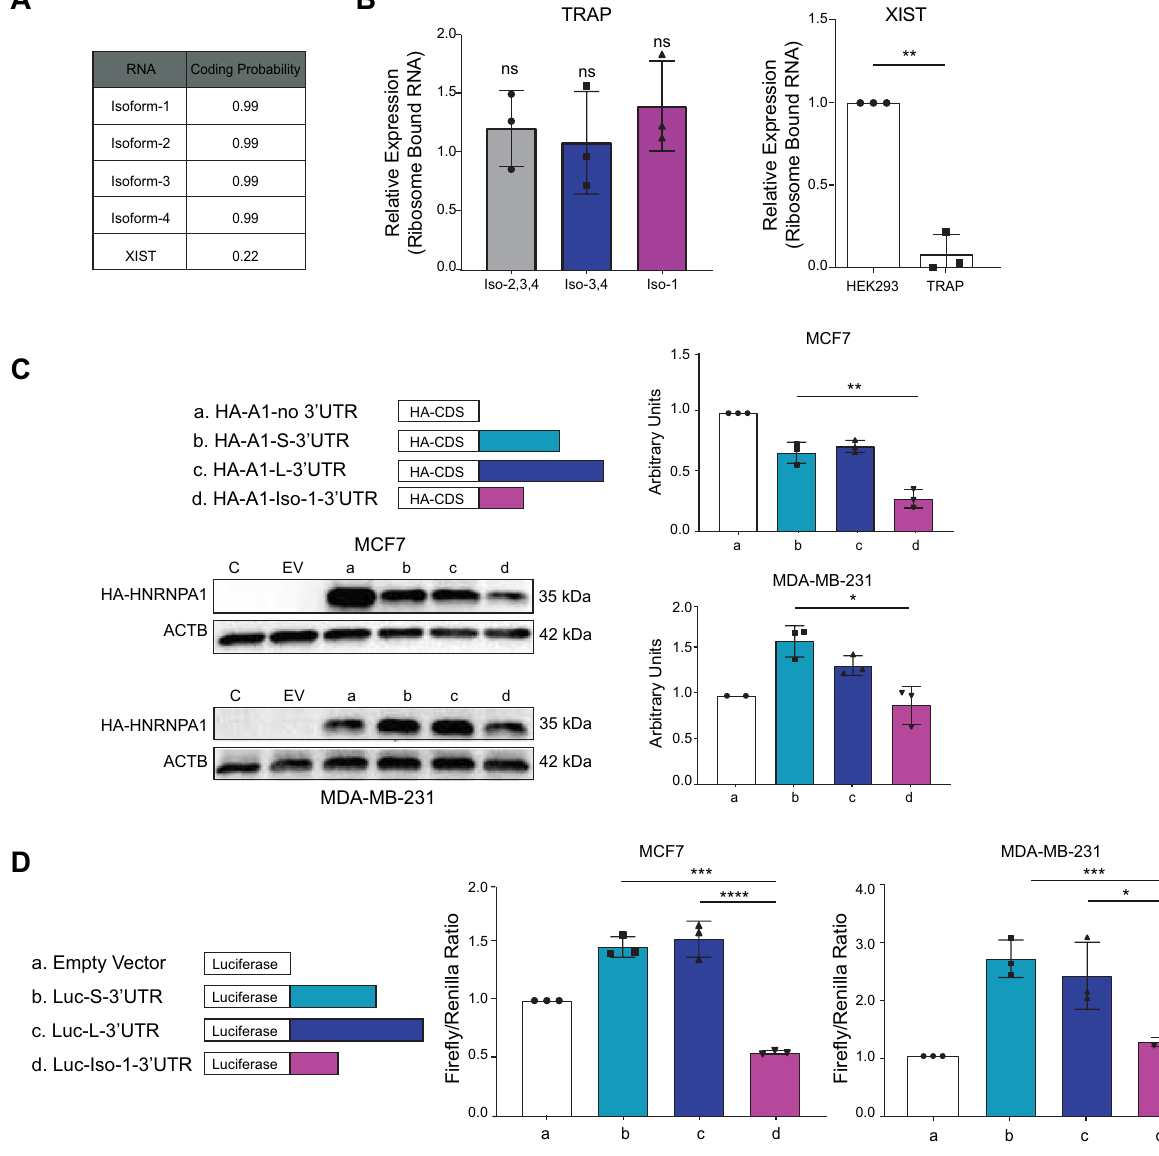
Figure 3. Translation of HNRNPA1 isoforms. ( A ) Coding potentials of HNRNPA1 isoforms determined by CPC2 are shown. XIST is a non-coding RNA. ( B ) TRAP in EGFP-L10A expressing HEK293 cells. Levels of TRAP RNAs were normalized to their expression values in untransfected HEK293 cells to eliminate the bias of expression levels (ns: not significant, n = 3 independent RNA-IPs, one-way ANOVA, Tukey’s HSD). XIST, a non-coding RNA, was used as a negative control (**p < 0.01; n = 3, Student’s t-test). ( C ) Cells were transiently transfected with indicated vectors, and lysates were collected. HA antibody was used to detect HNRNPA1 levels. Same blots were hybridized with ACTB antibody. The image is representative of 3 independent experiments. Graphs show densitometric quantification of bands (*p < 0.05, **p < 0.01, one-way ANOVA, Tukey’s HSD), uncropped images are presented in Supplementary Fig. S13. ( D ) Different 3 ′ UTRs were cloned downstream of the luciferase gene in the pMIR vector. Cells were transiently transfected, and Firefly/Renilla luciferase read- outs from the constructs were normalized to that of empty pMIR (*p < 0.05, **p < 0.01, ****p < 0.0001; n = 3 independent transfections, one-way ANOVA, Tukey’s